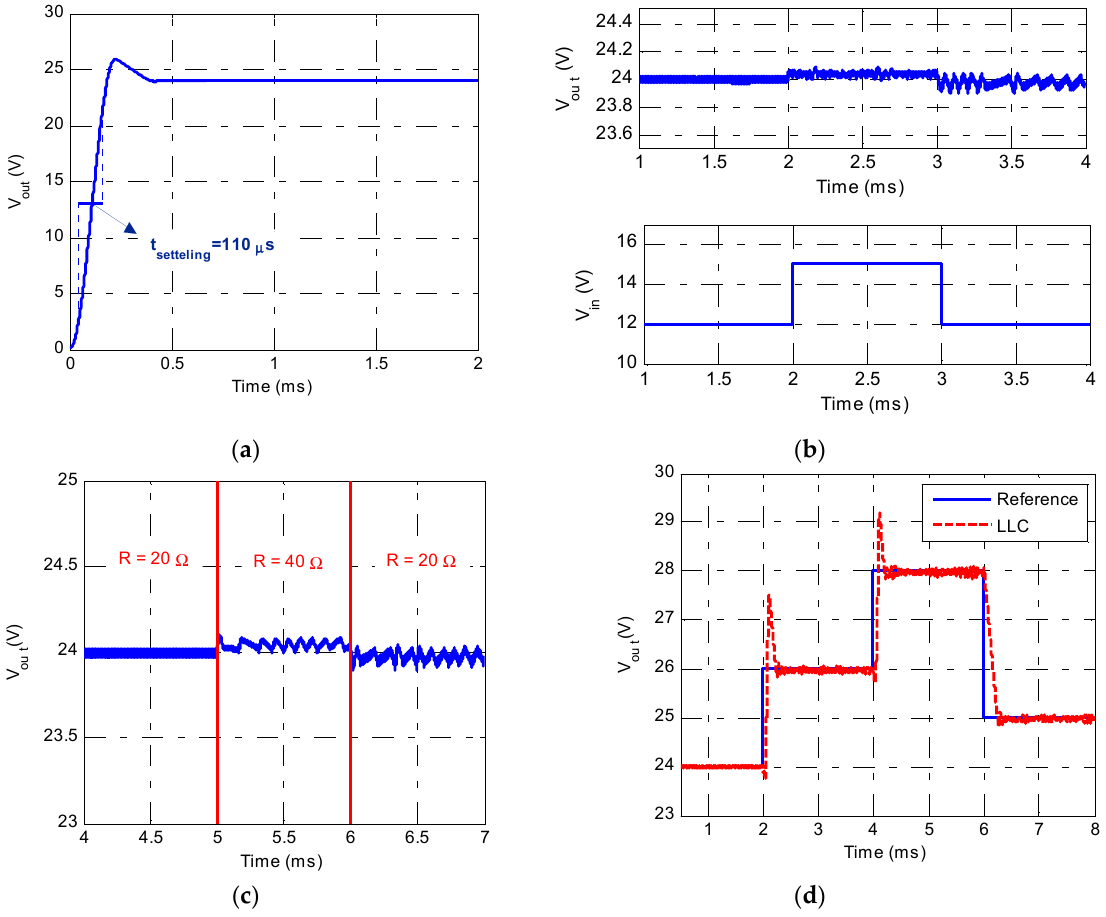
Figure 6. ( a ) Boost converter step response for 24 V reference output voltage; ( b ) response to variations in source voltage; ( c ) response to load variations; and ( d ) ability of the proposed LLC to reference voltage tracking. Table 2. Numerical evaluations of the step response achieved by the proposed